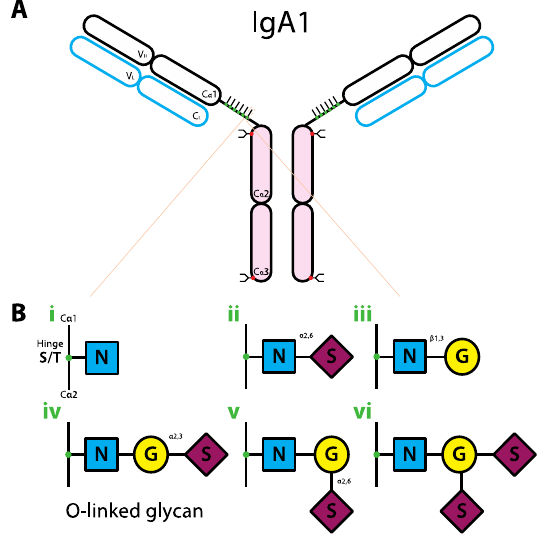
Figure 3. Schematic representation of the human IgA1 structure and glycan composition. ( a ) IgA1 structure. IgA1 protein is comprised of two heavy chains (black outline) and two light chains (blue outline). Each IgA heavy chain is comprised of the variable region (V and the constant region containing three domains (C α 1-3). The line between C α 1 and C α 2 represents the hinge region. Each light chain has variable (V IgA1 molecule can be divided into antigen-binding fragment (Fab; empty ovals) and fragment crystallizable region (Fc; pink ovals). The red and green dots represent the complex-type N-linked and O-linked glycans, respectively. ( b ) Composition of O-linked glycans on IgA1. The glycans can have six different variants (i–vi). Abbreviations: N, GlcNAc; G, galactose; S, sialic